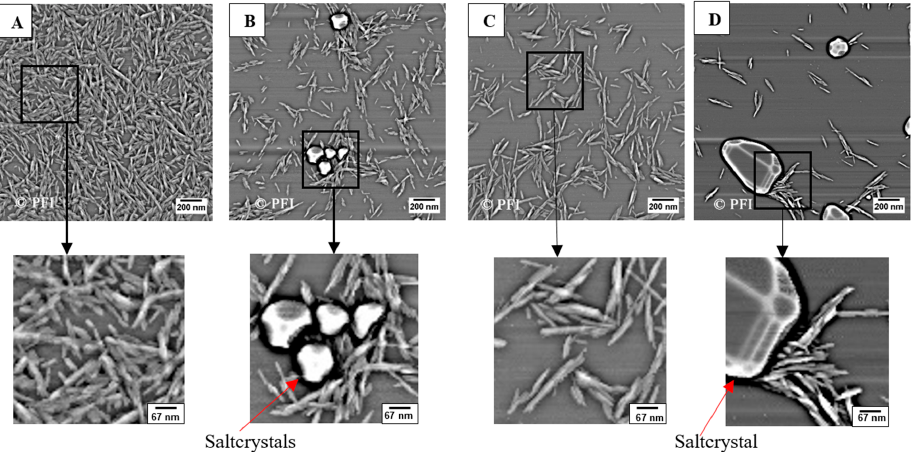
Figure 8. Image ( A , B ) is 0.02 wt. % CNC (USDA) in deionized water and 0.1 wt. % NaCl, while image ( C , D ) is 0.02 wt. % CNC (AITF) in DIW and 0.1 wt. % NaCl, respectively. The round shapes in image ( B , D ) are salt crystals. For all the images, a small section has been enlarged three times to make it easier to see the fibrils and salt crystals in more detail.